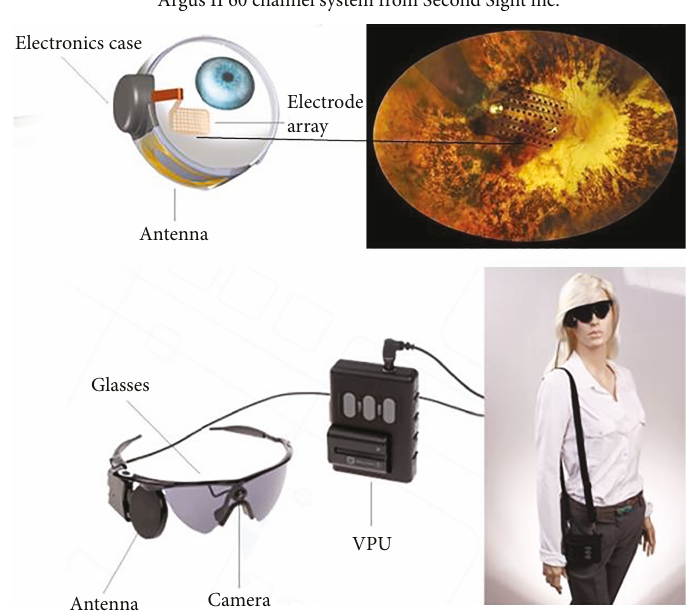
Figure 2: Epiretinal visual prosthesis consists of a highly fl exible electrode array tacked onto the inner surface of the retina, which is connected to a multichannel stimulator that is strapped to the eyeball and receives power and command signals from an external video camera and video processing unit (VPU) via an externally generated radio-frequency magnetic fi eld. Photos used with permission of the manufacturer, Second Sight Inc., Sylmar, CA